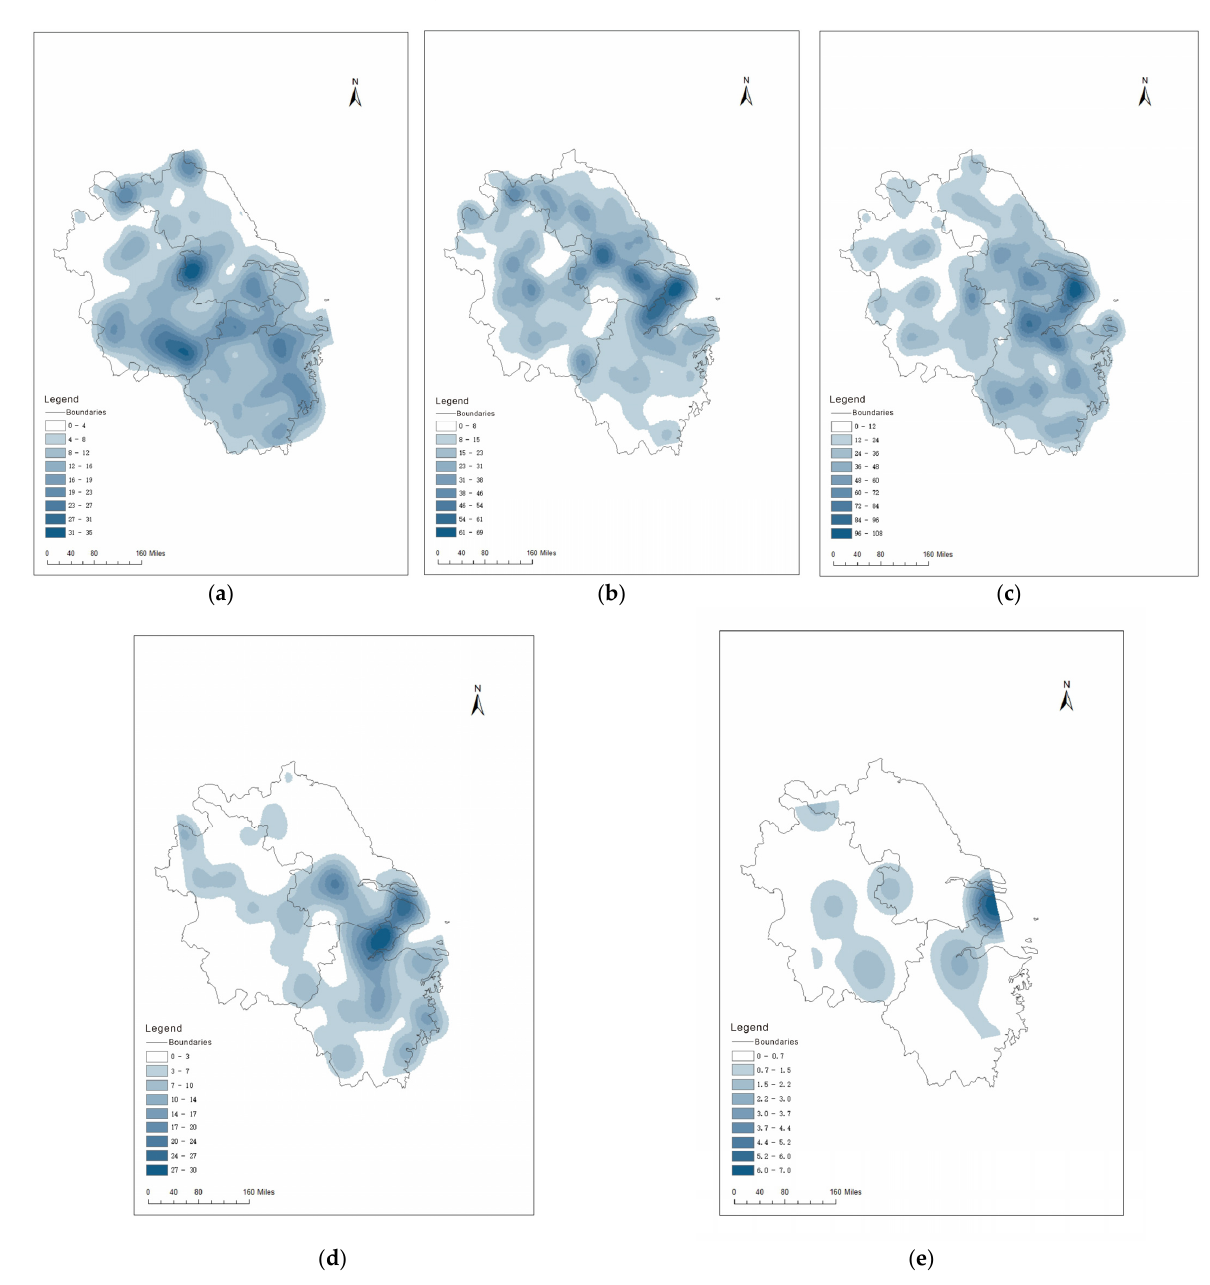
Figure 2. Kernel density of the five types of tourist attractions ( a ) Natural ecological tourist attractions; ( b ) Historical and cultural tourist attractions; ( c ) Modern recreational tourist attractions; ( d ) Industrial integration of tourist attractions; and ( e ) Other kinds of tourist attractions.